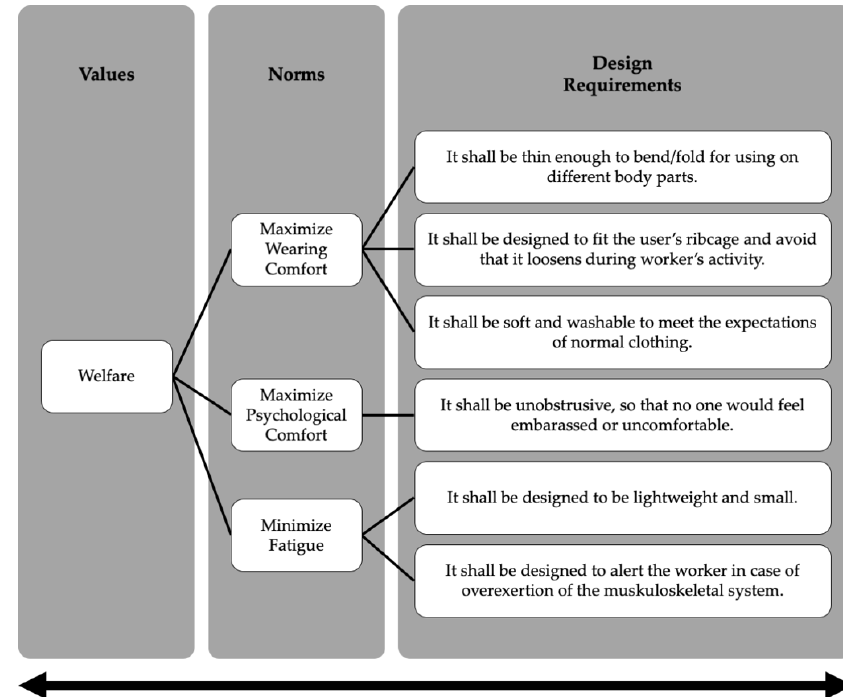
Figure 10. Bi-direction hierarchy showcasing how the value of welfare can be translated through norms and into technical design requirements for wearable technology. 600